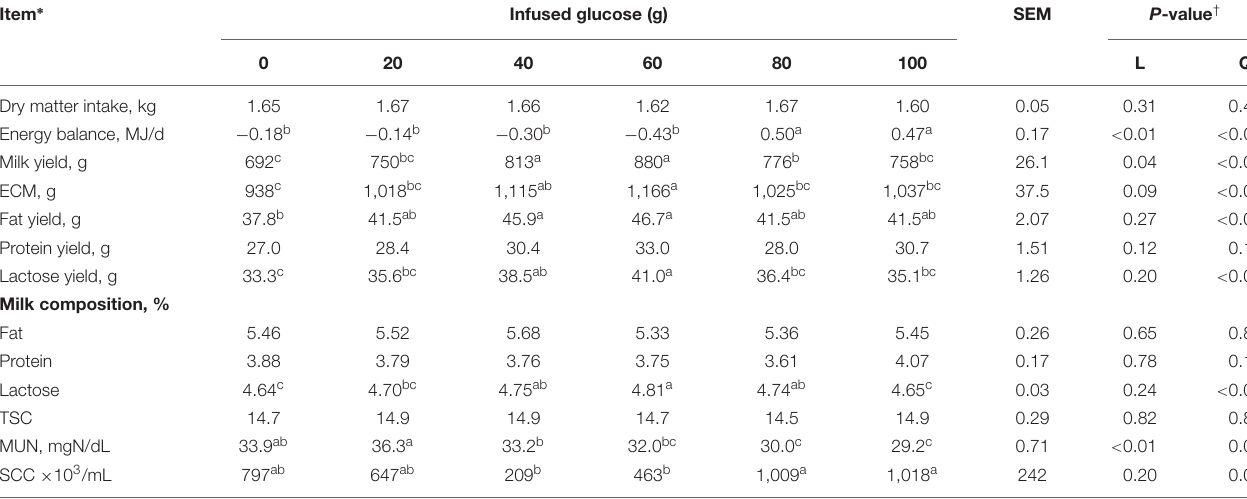
TABLE 2 | Effects of increasing mammary glucose supply by external pudendal artery on feed intake, energy balance, and milk production.